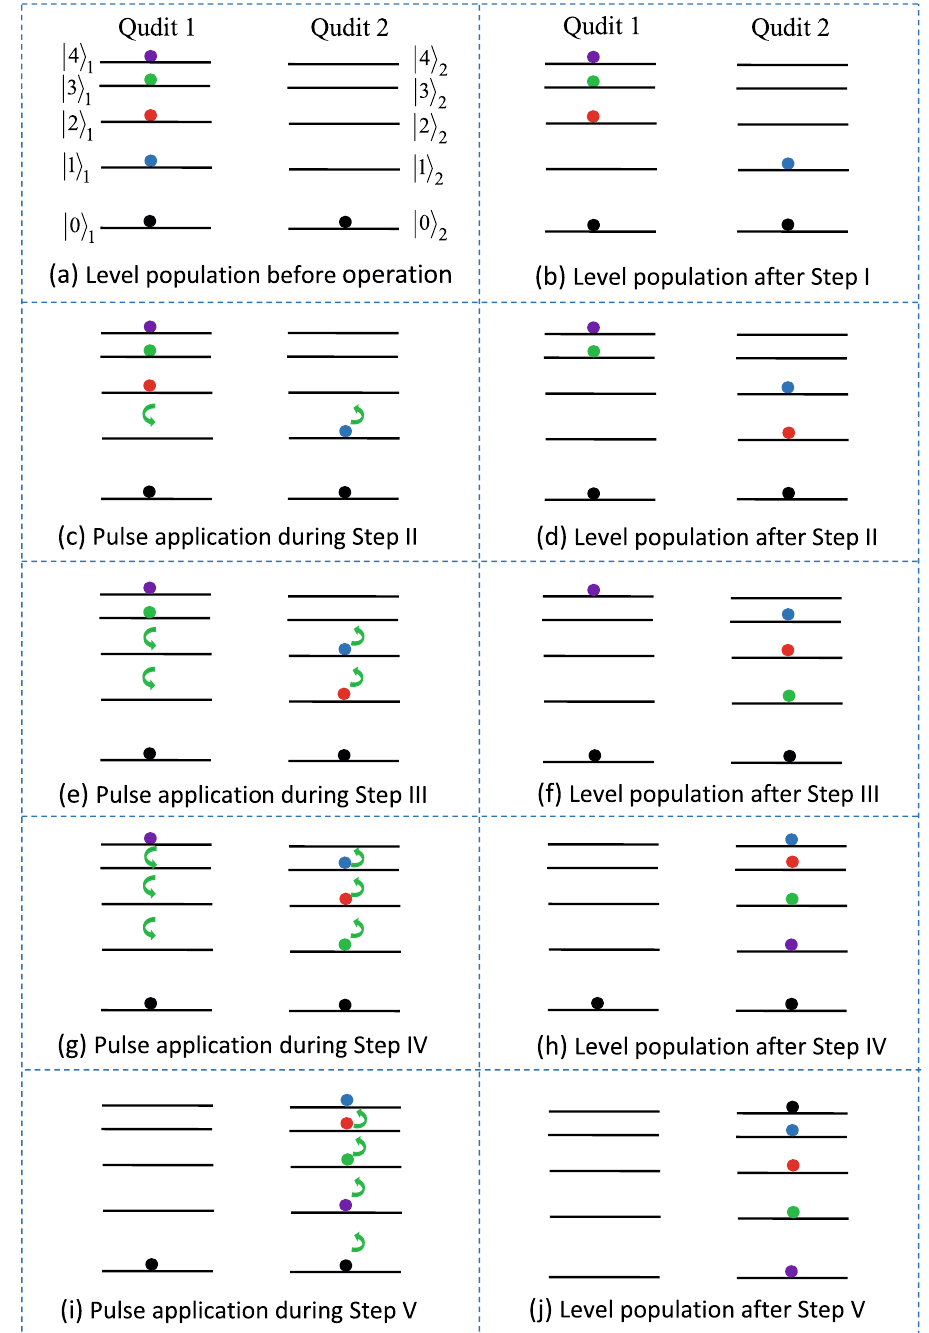
Figure 2. The color circles indicate the occupied energy levels. Each green arrow represents a classical pulse, which is resonant with the transition between the two neighbor levels close to each green arrow. In ( e ) and ( g ), the sequence for applying the pulses is from top to bottom, and the lower pulses are turned on after the upper pulses are switched off. In ( i ), the sequence for applying the pulses is from bottom to top, and the upper pulses are turned on after the lower pulses are switched off. For the details on the applied pulses, see the descriptions given in the text. Note that in ( a – j ), the left levels are for qudit 1 while the right levels are for qudit 2. For simplicity, we here consider the case that the spacings between adjacent levels become narrow as the levels move up, which is actually